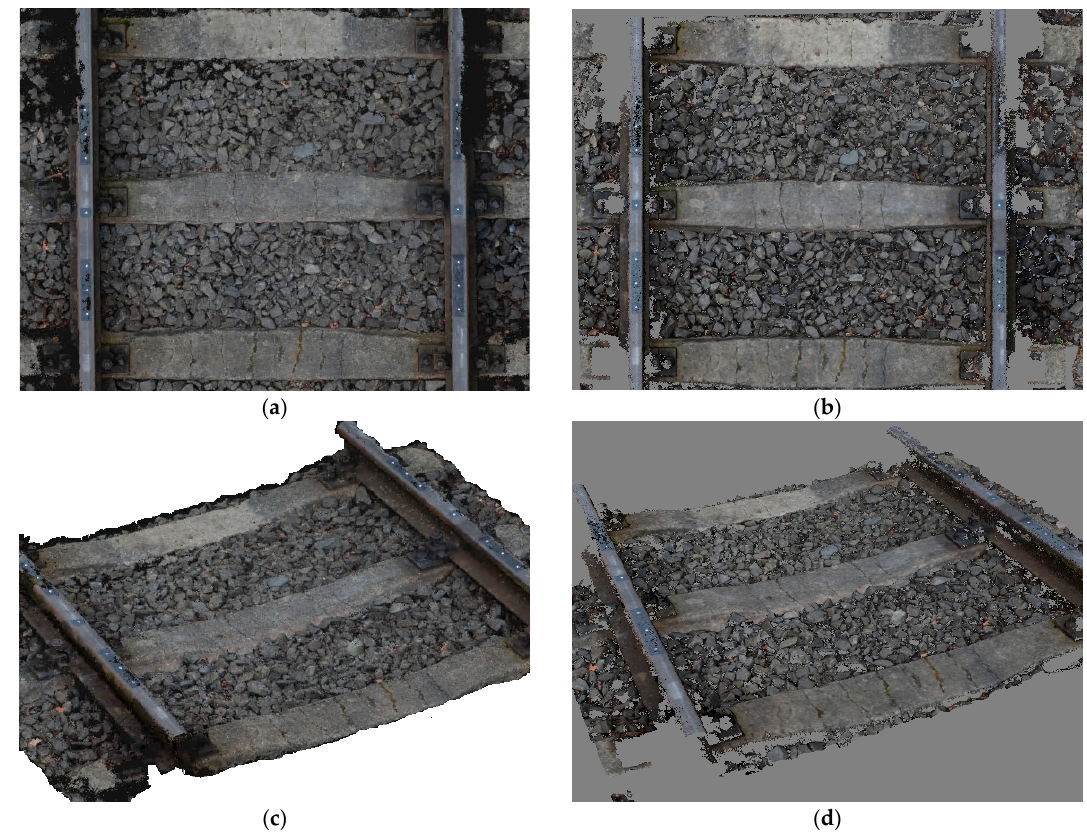
Figure 5. Generated 3D mesh model of the railway track (top and solid view) in Reality Capture ( a , c ) and PhotoScan ( b , d ) software.